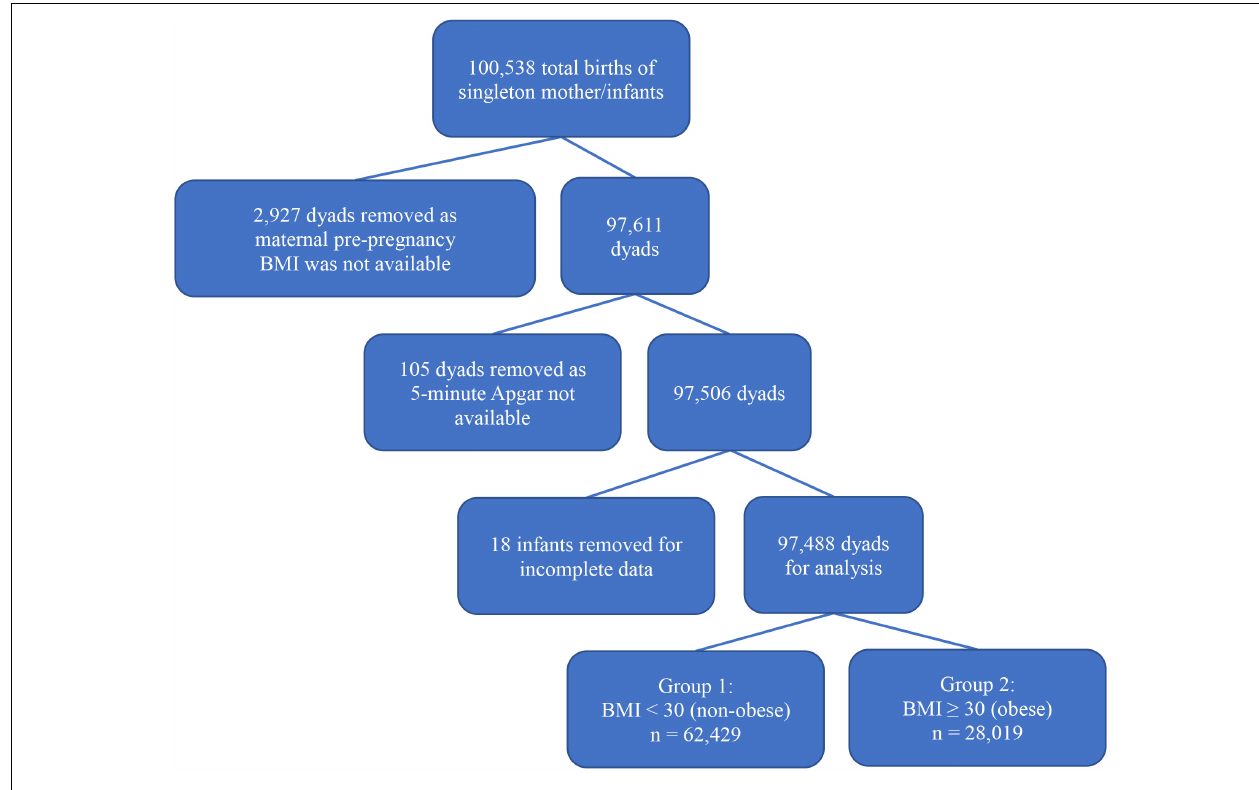
FIGURE 2 | Flow diagram of mother-infant selection.